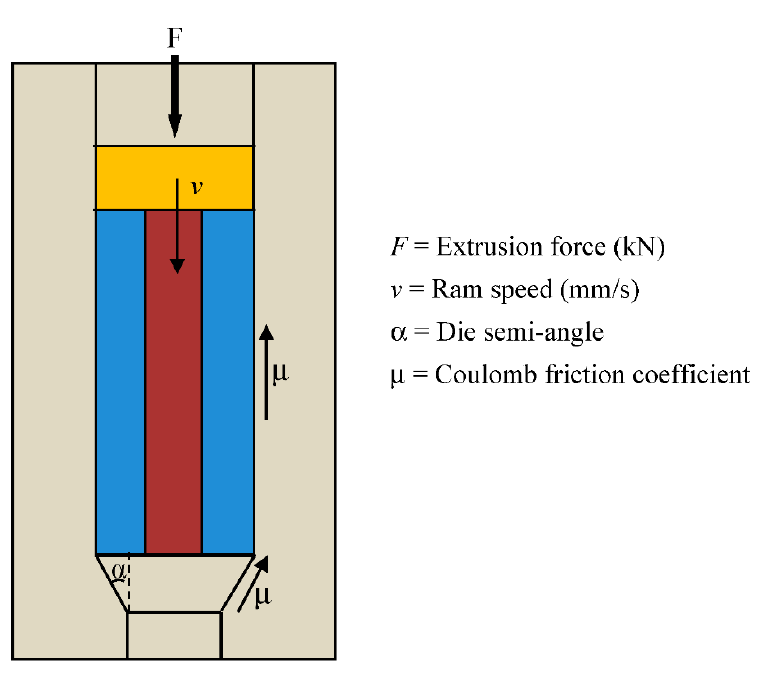
Figure 2. Extrusion process schema.